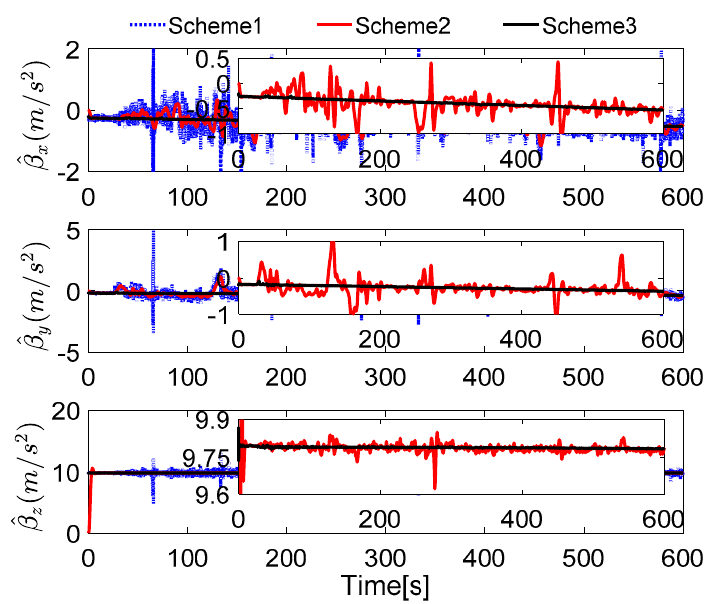
Figure 18. Curves of the reconstructed observation vectors.